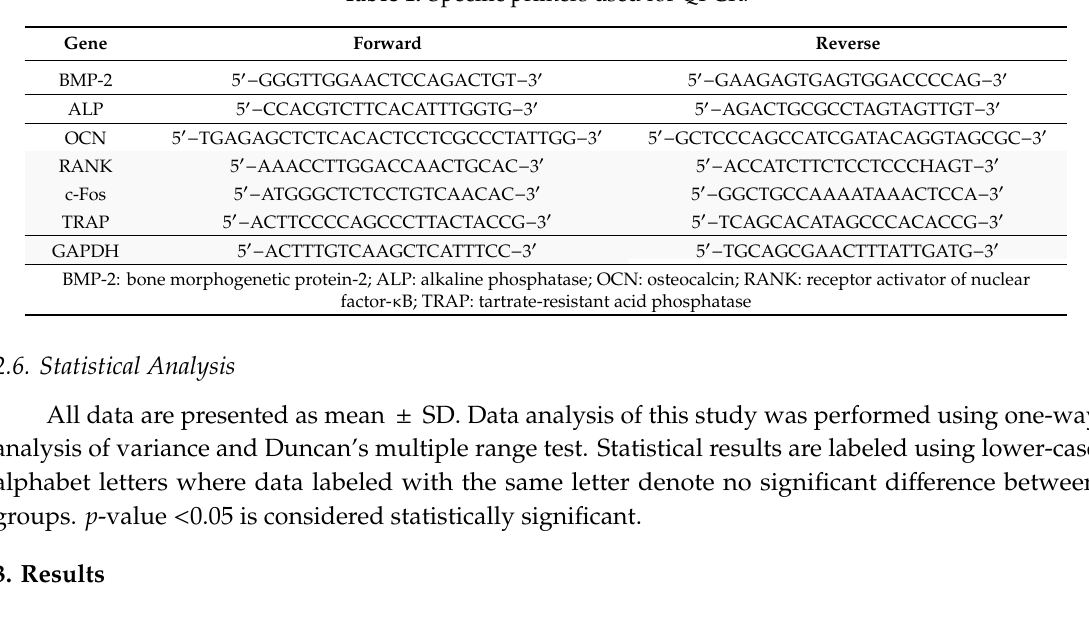
Table 1. Specific primers used for